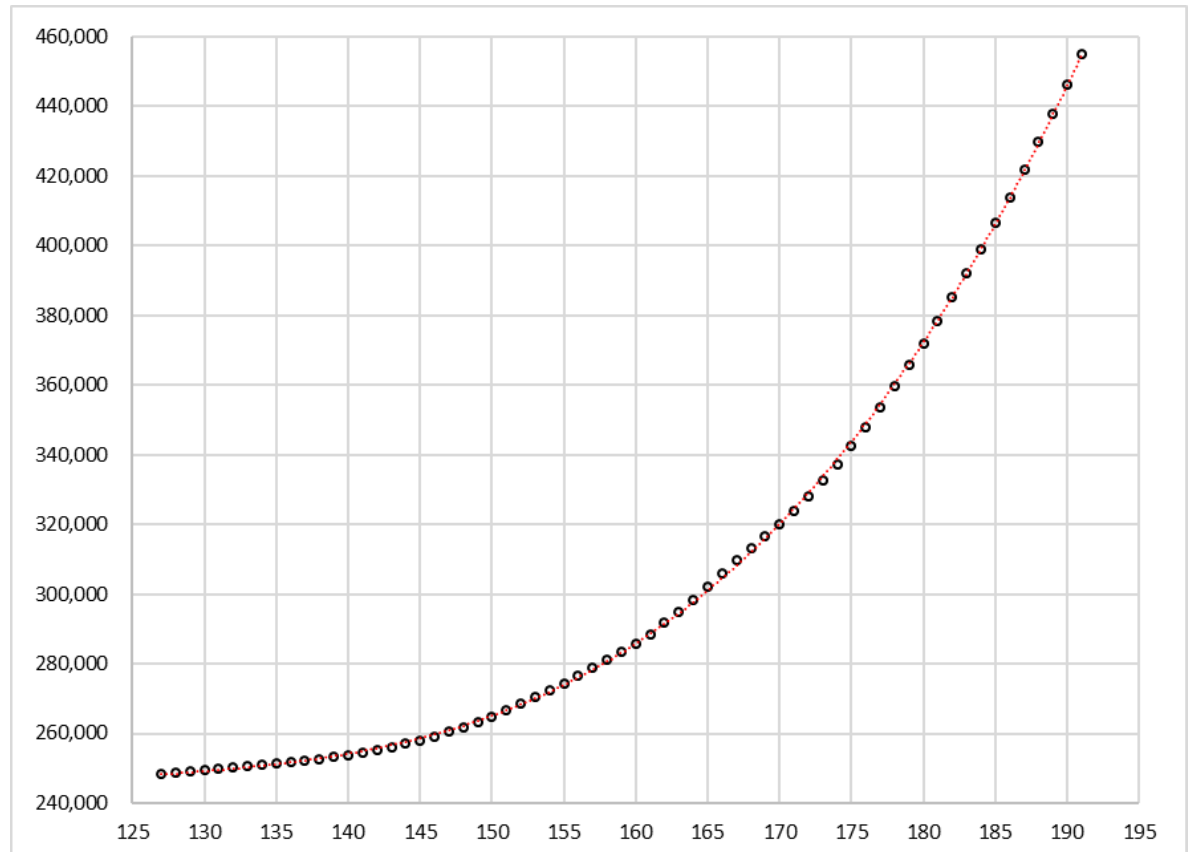
Figure 9. Seven day average estimation between 29 June and 2